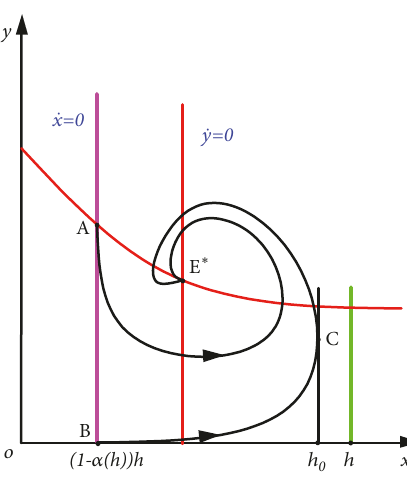
Figure 3: The existence of the OOPS of system (2) if ℎ > ℎ 0 in Case